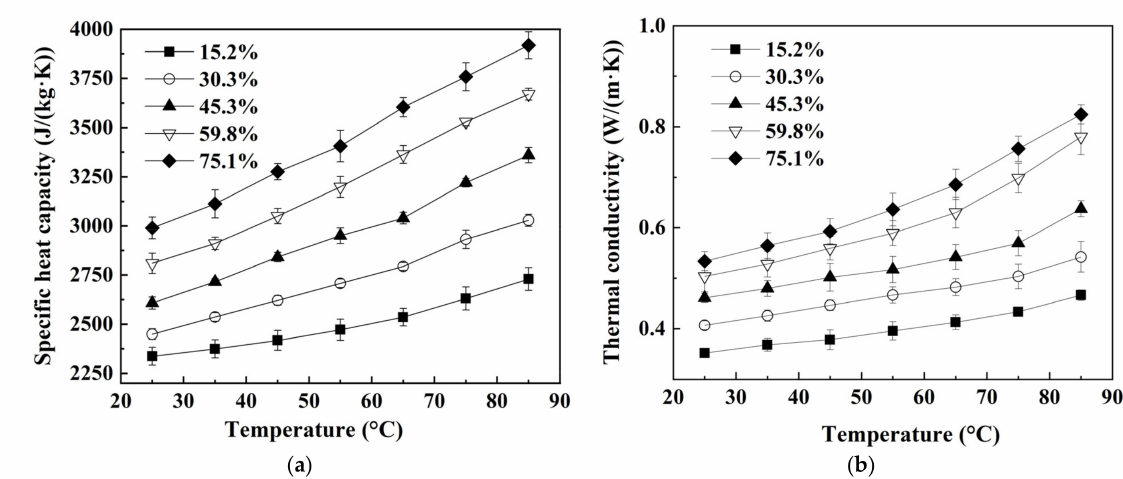
Figure 1. Moisture content and temperature-dependent specific heat capacity ( a ) and thermal con- ductivity ( b ) of